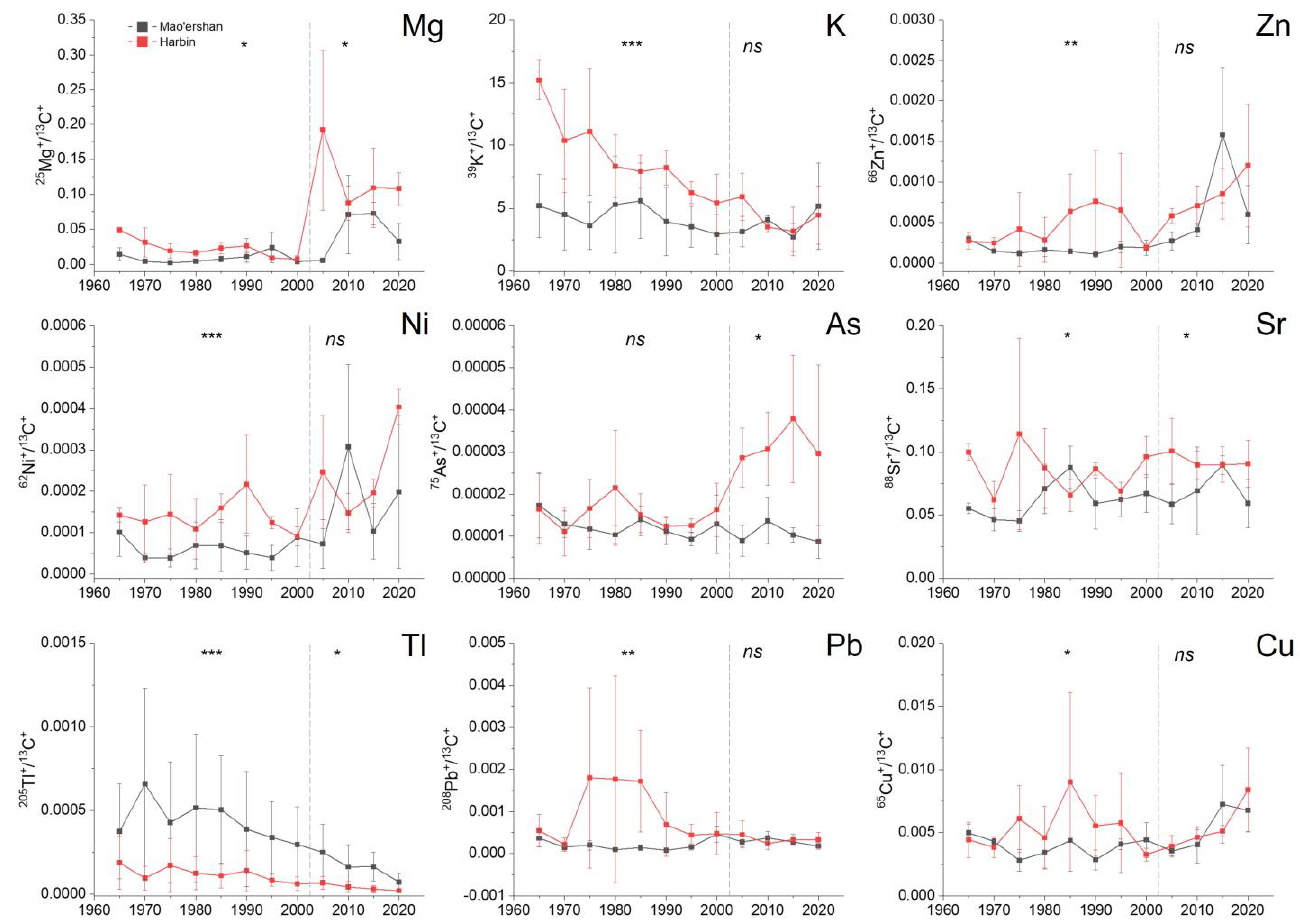
Figure 5. Elemental signal in the Harbin and Mao’ershan sites from 1965 to 2020. The two periods used in the statistical analyses are delineated by a dashed line. Kruskal-Wallis p values for statistical differences within each element between sites are shown for the two periods: “*” p < 0.05, “**” p < 0.01, “***” p < 0.001, “ ns ” not significant. Data show the means calculated from the highest value measured per tree ring ± standard deviation (n = 3).